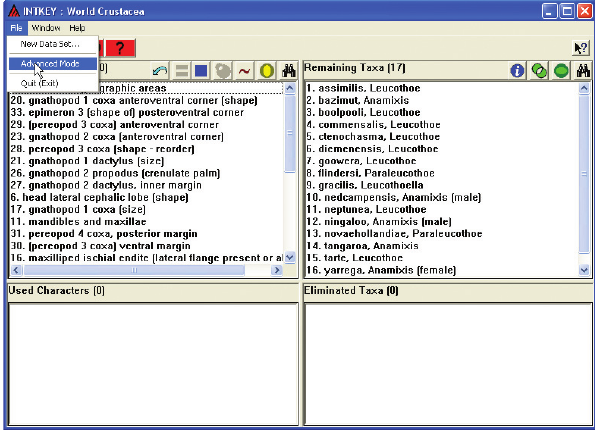
Figure 62. Switching into Advanced mode .